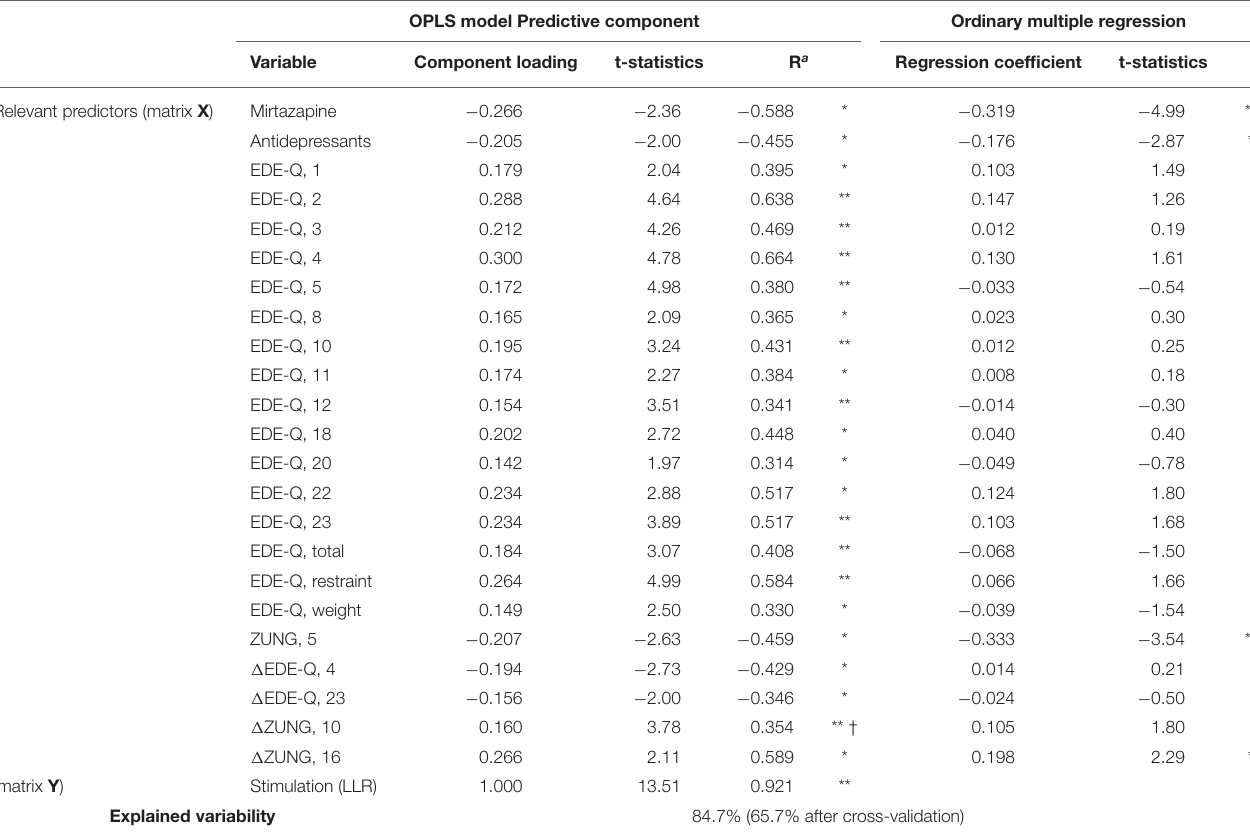
TABLE 5 | Relationships between the effect of Stimulation (stimulated vs. non-stimulated patients, logarithm of the likelihood ratio, and LLR) and other parameters as evaluated by the OPLS model and ordinary multiple regression (for details, see Statistical Analysis ). OPLS model Predictive